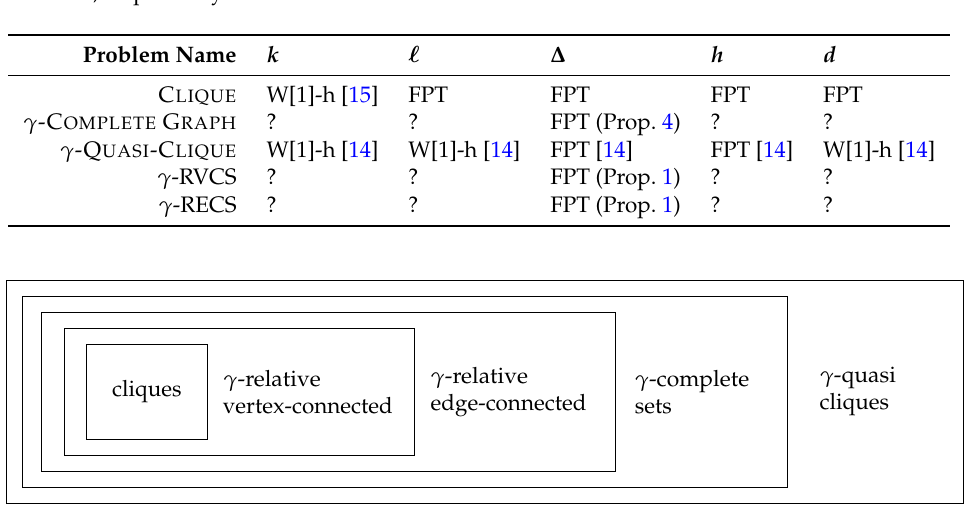
Figure 8. Inclusion diagram for clique relaxations using a relative relaxation parameter γ ; the inclusions hold for every fixed γ . For example, a 0.5-relative-edge-connected set is a